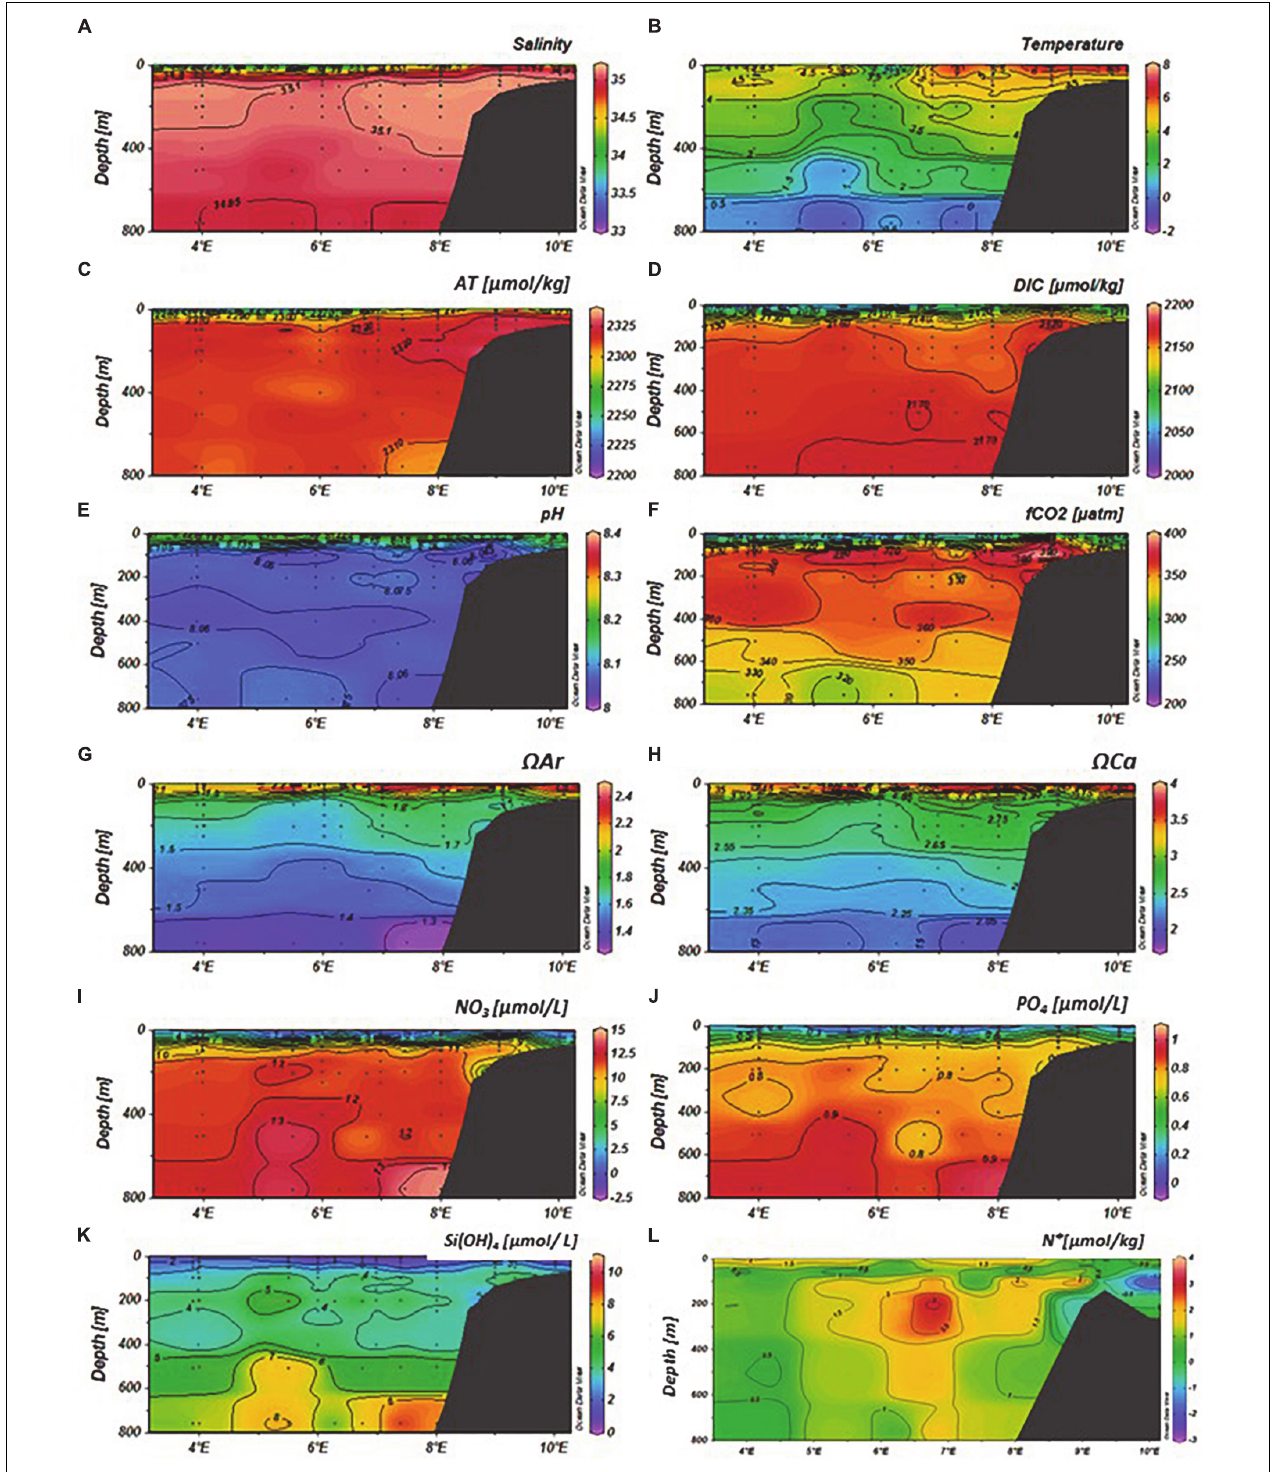
FIGURE 6 | Variability of physical and chemical parameters in the eastern Fram Strait (latitude: 79–79.5 ◦ N, longitude: 4–10 ◦ E) in August 2014 from top; (A) salinity, (B) temperature ( ◦ C), (C) total alkalinity (AT, µ mol kg − 1 ), (D) total dissolved inorganic carbon (DIC, µ mol kg − 1 ), (E) pH, (F) fugacity of carbon dioxide ( f CO 2 , µ atm), (G) aragonite saturation ( (cid:127) Ar), (H) calcite saturation ( (cid:127) Ca), (I) nitrate (NO 3 , µ mol L − 1 ), (J) phosphate (PO 4 , µ mol L − 1 ), (K) silicic acid (SiOH 4 , µ mol L − 1 ), and (L) N ∗ ( µ mol kg − 1 , negative values denote denitrification, and positive values show nitrification). The sampling locations and depths are denoted as black dots. The section plot and interpolation were performed by the Ocean Data View program (Schlitzer,